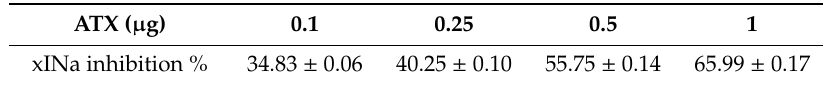
Table 1. Amiloride-sensitive sodium current amplitude variation as a function of ATX concentration (4–6